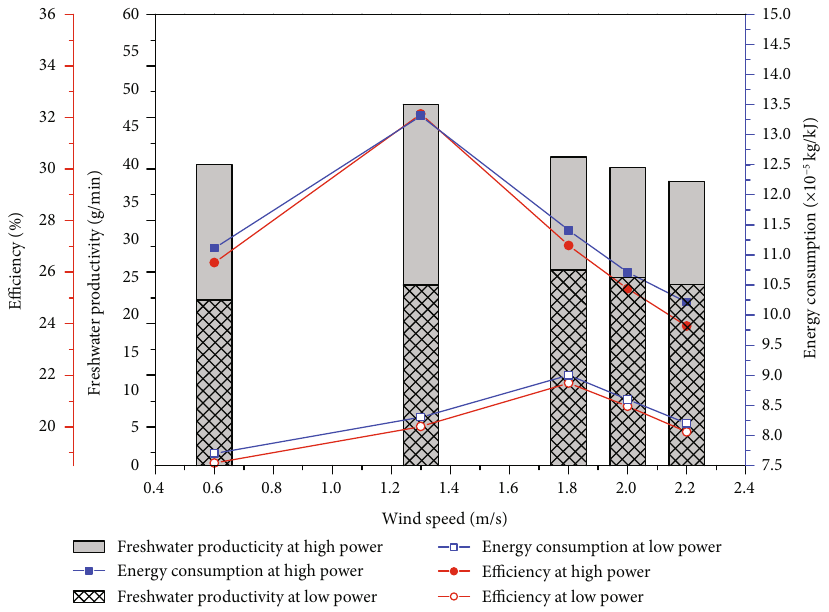
Figure 8: Freshwater productivities, thermal e ffi ciencies, and energy consumption under di ff erent heating